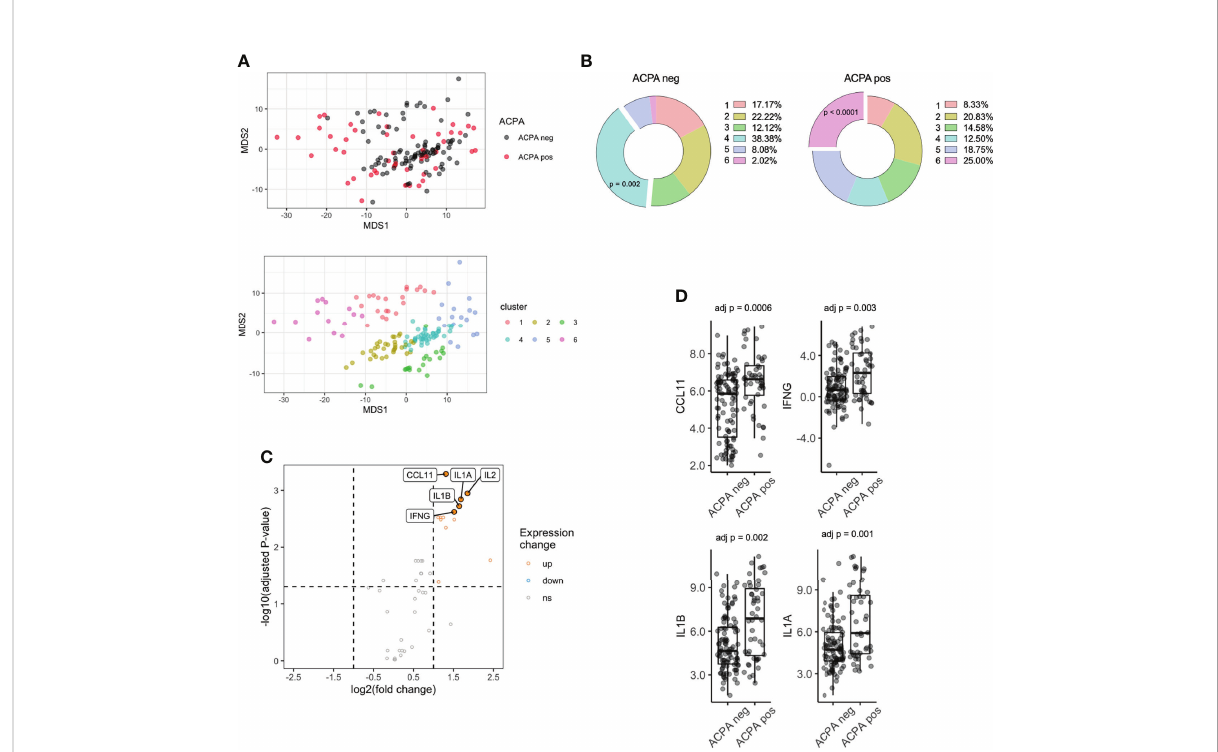
FIGURE 1 Serum proteomics differences between ACPA positive and ACPA negative FDR of RA patients. (A) Multi-dimensional scaling (MDS) plot of FDR sera based on 48-plex proteomics coloured by ACPA status (top) or consensus cluster (bottom, n = 6). (B) Cluster assignment enrichment based on ACPA status. Clusters analyzed by chi-square test. (C) Volcano plot of differentially expressed proteins, colored by upregulated (fold change > 2) and downregulated (fold change < 0.5) in ACPA positive group. Analyzed by pairwise t-test adjusted by Benjamini-Hochberg. (D) Box plots of CCL11, IFNG, IL1B, IL1A comparing ACPA positive and ACPA negative groups. ACPA, anti-citrullinated protein antibodies; FDR, fi rst-degree relatives; CCL11, C-C Motif Chemokine Ligand 11; IFNG, Interferon gamma; IL1B, Interleukin 1 Beta; IL1A, Interleukin 1 Alpha. ns = not signi fi